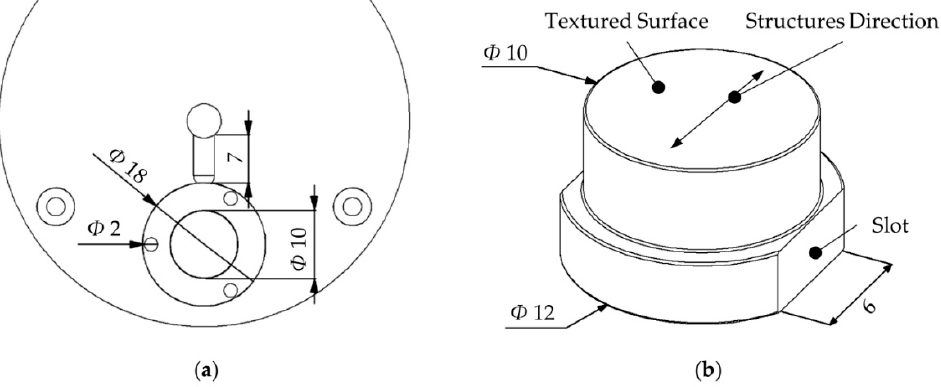
Figure 2. ( a ) Design of the mold cavity. ( b ) Design of the textured insert and alignment features. (All dimensions are in millimeters.)